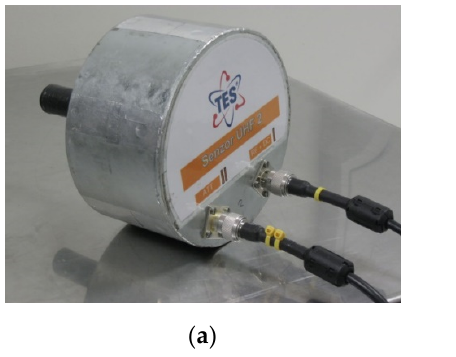
Figure 5. The principal schematic of the PD UHF sensor unit.